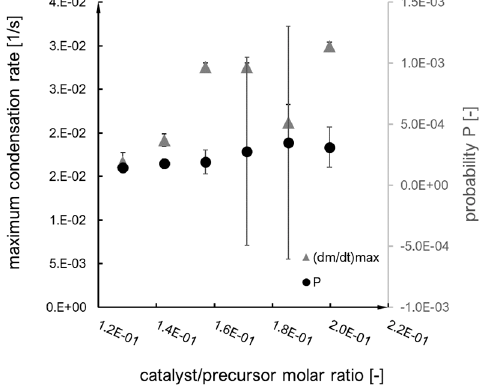
Figure 8. First phase, second phase and gelation time for the A–F syntheses.